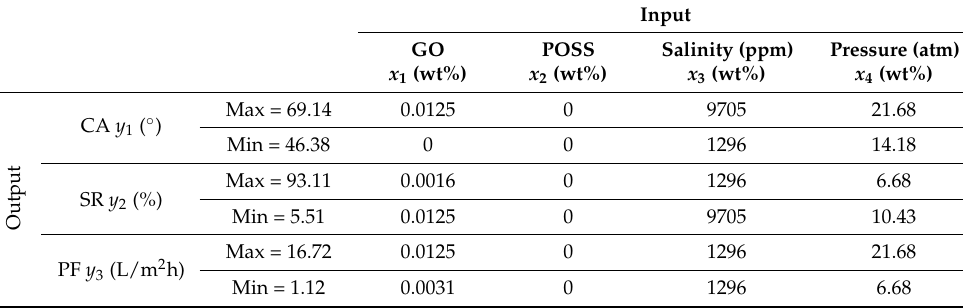
Table 5. Global maximum and minimum outputs predicted from Equation